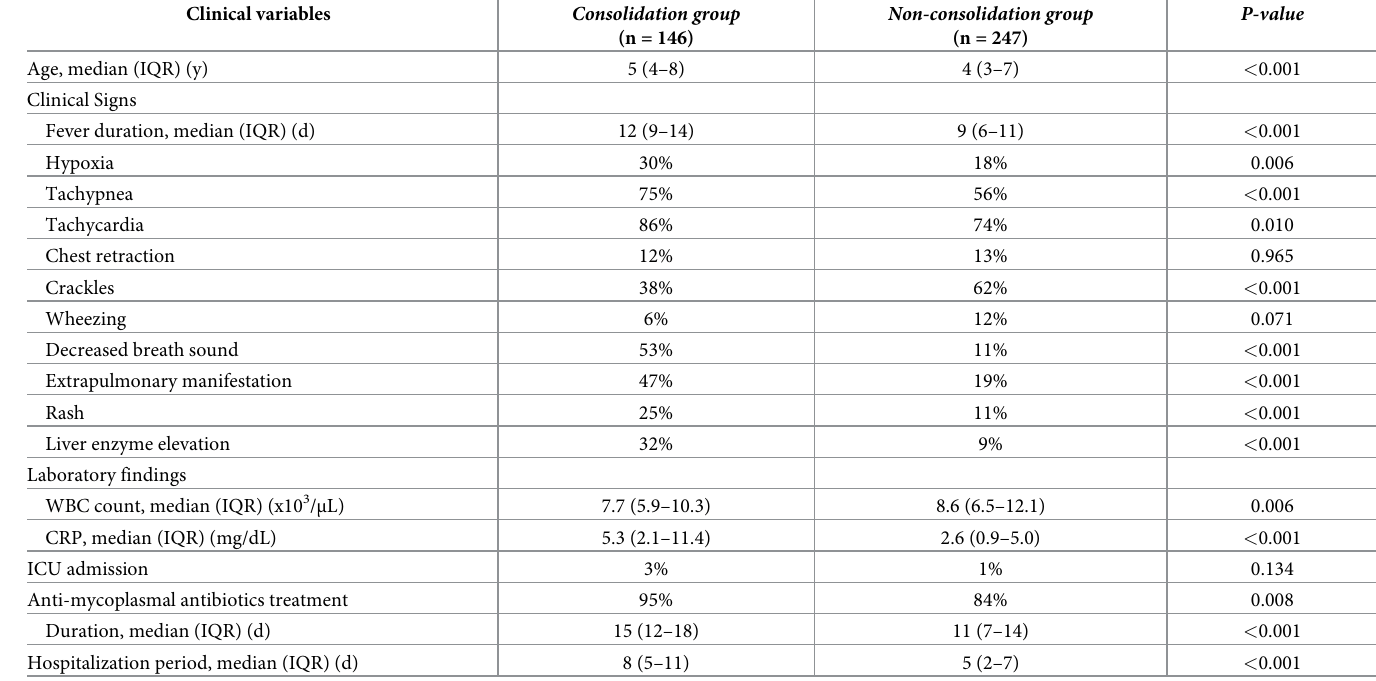
Table 2. Association between chest radiograph findings and clinical manifestations in children with Mycoplasma pneumoniae pneumonia. Clinical